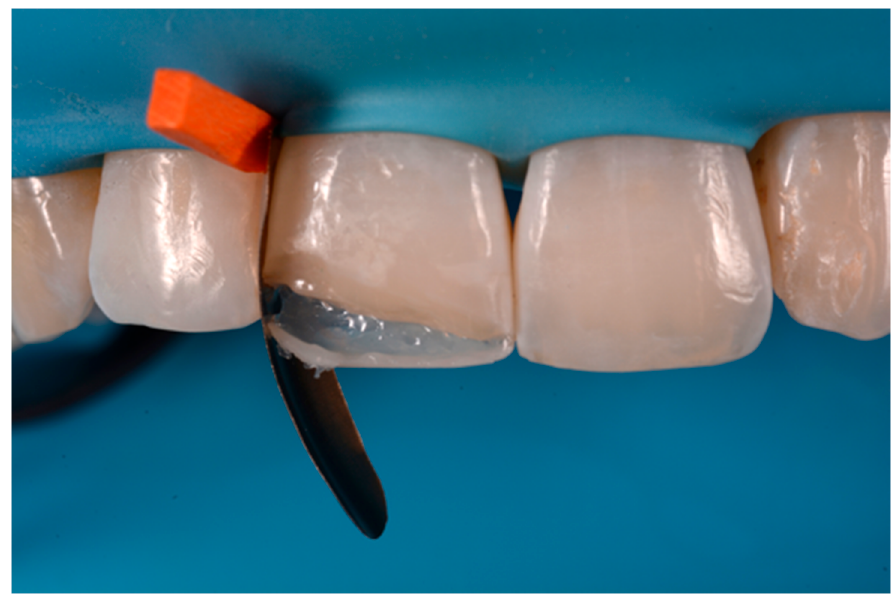
Figure 51. Sectional matrix applied to restore the distal wall.